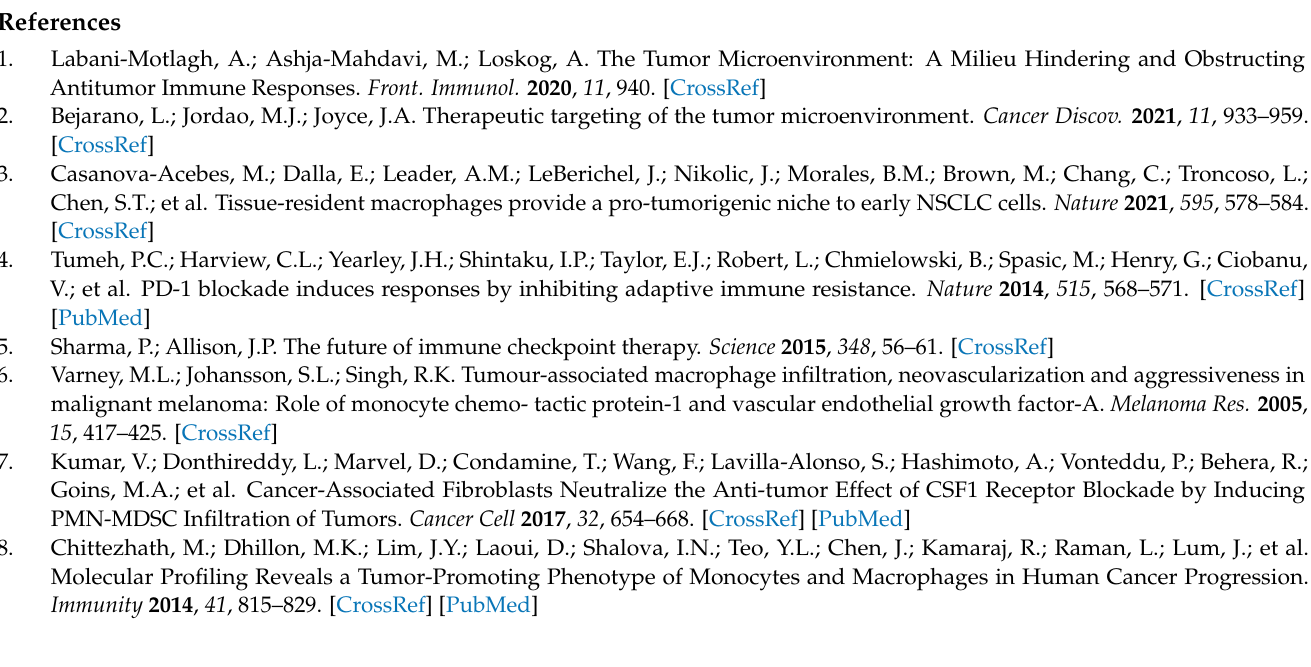
Figure S3: Rapid functional cell activation after early interactions in the 3D melanoma TME, Figure S4: Significant morphology and motility changes in BMDM activation in 3D co-cultures over time, Figure S5: Evolution and modeling of BMDM phenotype into a TAM-like state, Figure S6: BMDM transition into an immunosuppressive TAM-like functional pro- file after 7 days of 3D